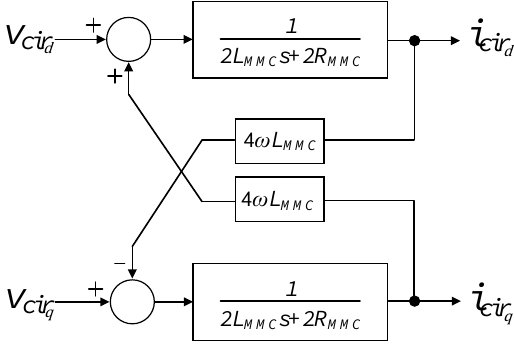
Figure 6. dq -frame circulating current model.